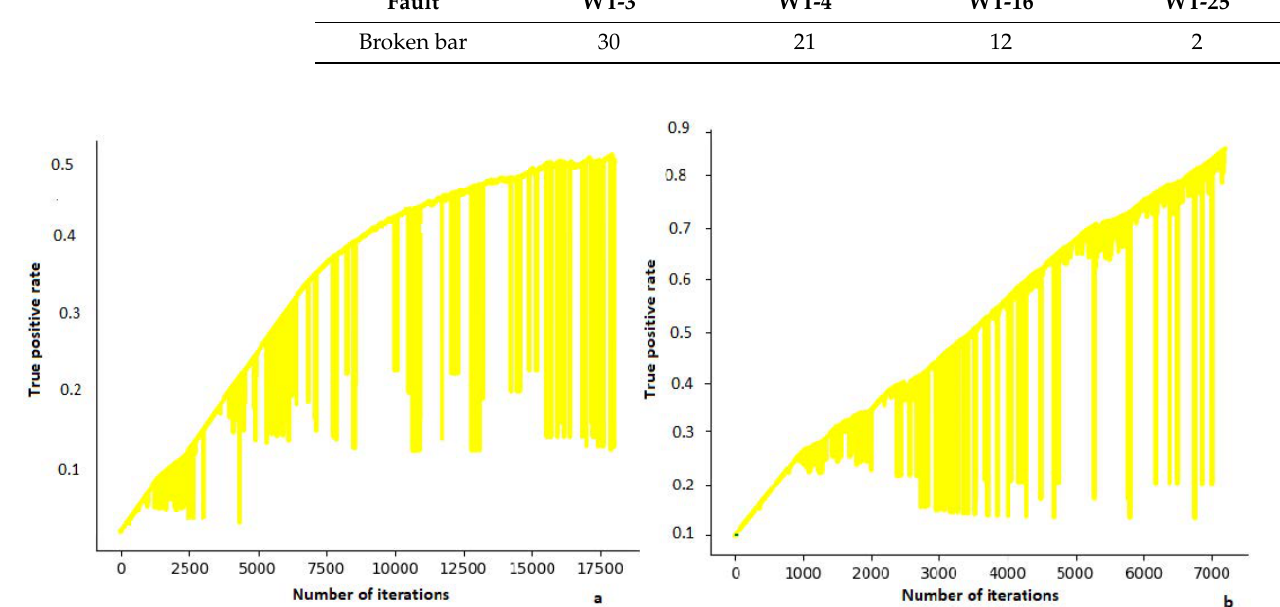
Figure 7. Precision in the detection of broken bars of the SCIG, using the proposal of [40]. ( a ) GANs with one GNN; ( b ) GANs with multiple GNNs.